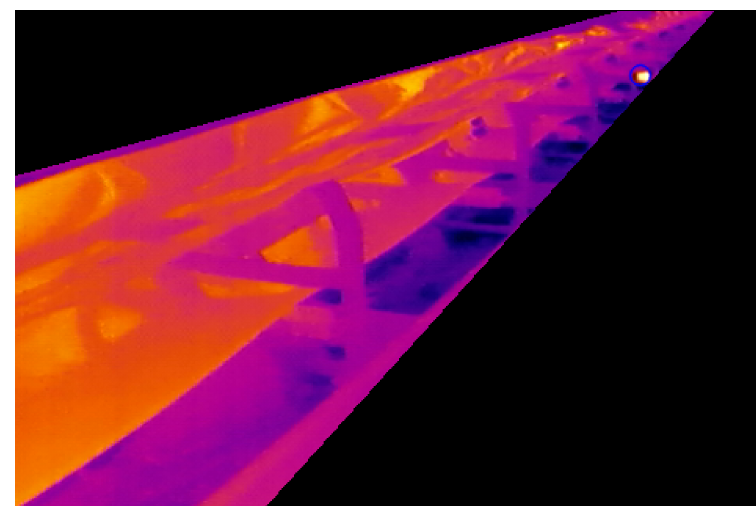
Figure 14. Result of damaged idler detection, example 3.